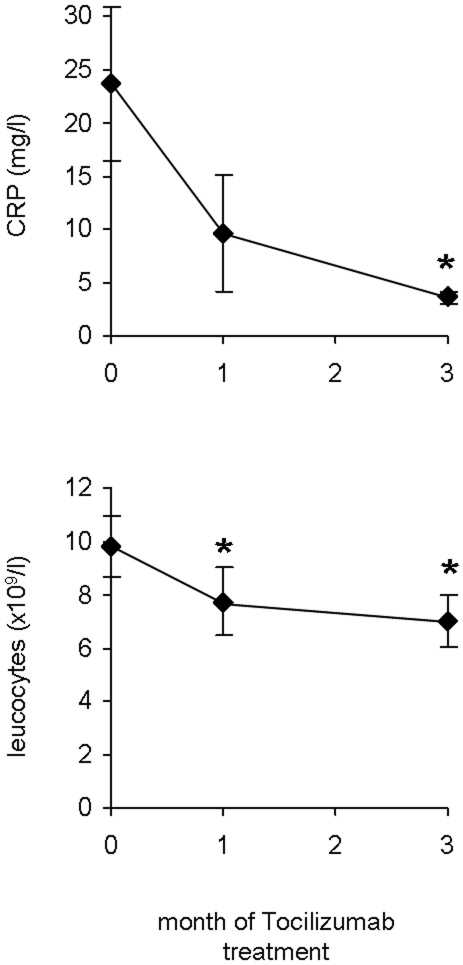
Effect of IL-6 inhibition on inflammatory parameters in human subjects.Data are expressed as Means ± SEM. * = p<0.05.